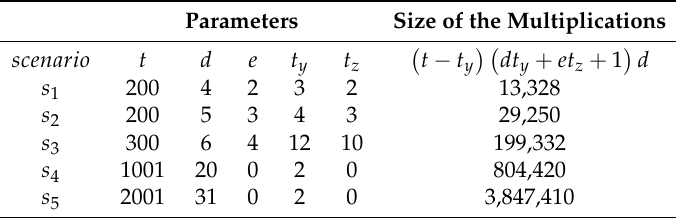
Table 1. Problem scenarios considered. Parameters and size of the multiplications when computing the fitness. Parameters Size of the